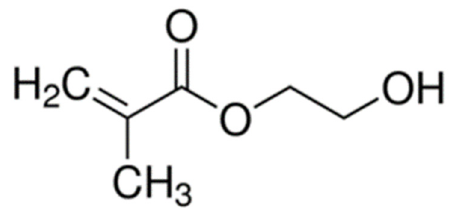
Figure 2. Schematic of 2-hydroxyethyl